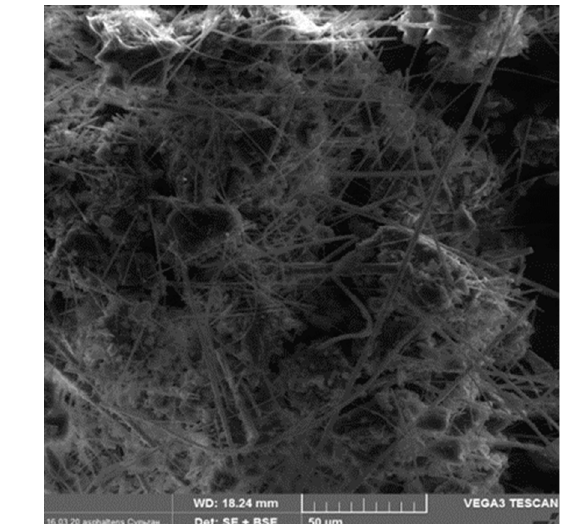
Figure 8. Electronic image of filter with sediment particles (sludge).